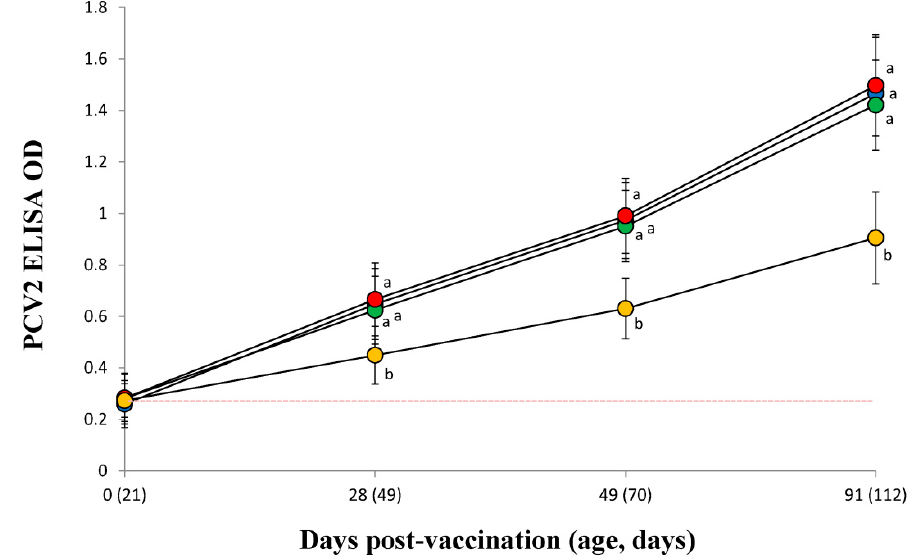
Figure 5. Mean values of the PCV2 antibodies by enzyme-linked immunosorbent assay (ELISA) in serum from VacS ( • ), VacPulse ( • ), VacEPIG ( • ), and UnVac ( • ) groups. Variation is expressed as the standard deviation. Serum samples are considered positive for PCV2 antibodies if the optical density (OD) is greater than 0.3 (red dotted line). Different superscripts (a and b) indicate significant ( p < 0.05) different among 4 groups.